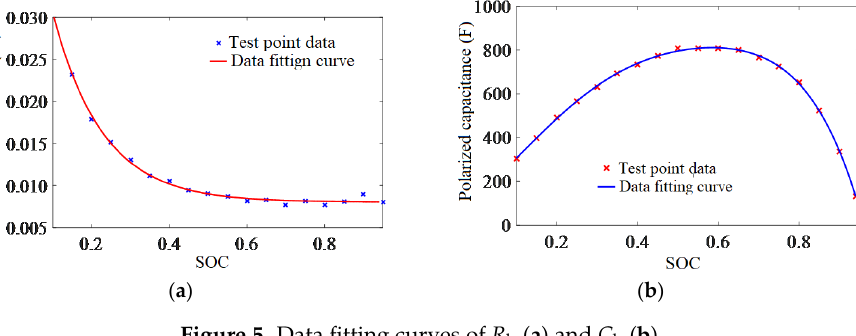
Figure 5. Data fitting curves of R b ( a ) and C b ( b ).